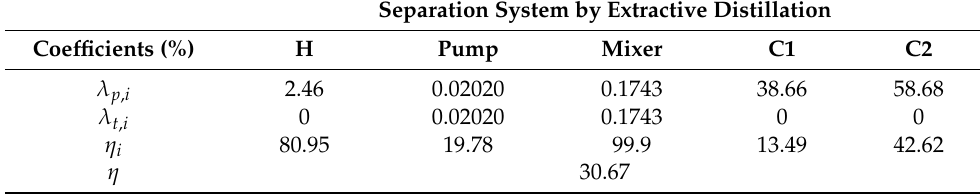
Table 4. Results of the exergy load distribution